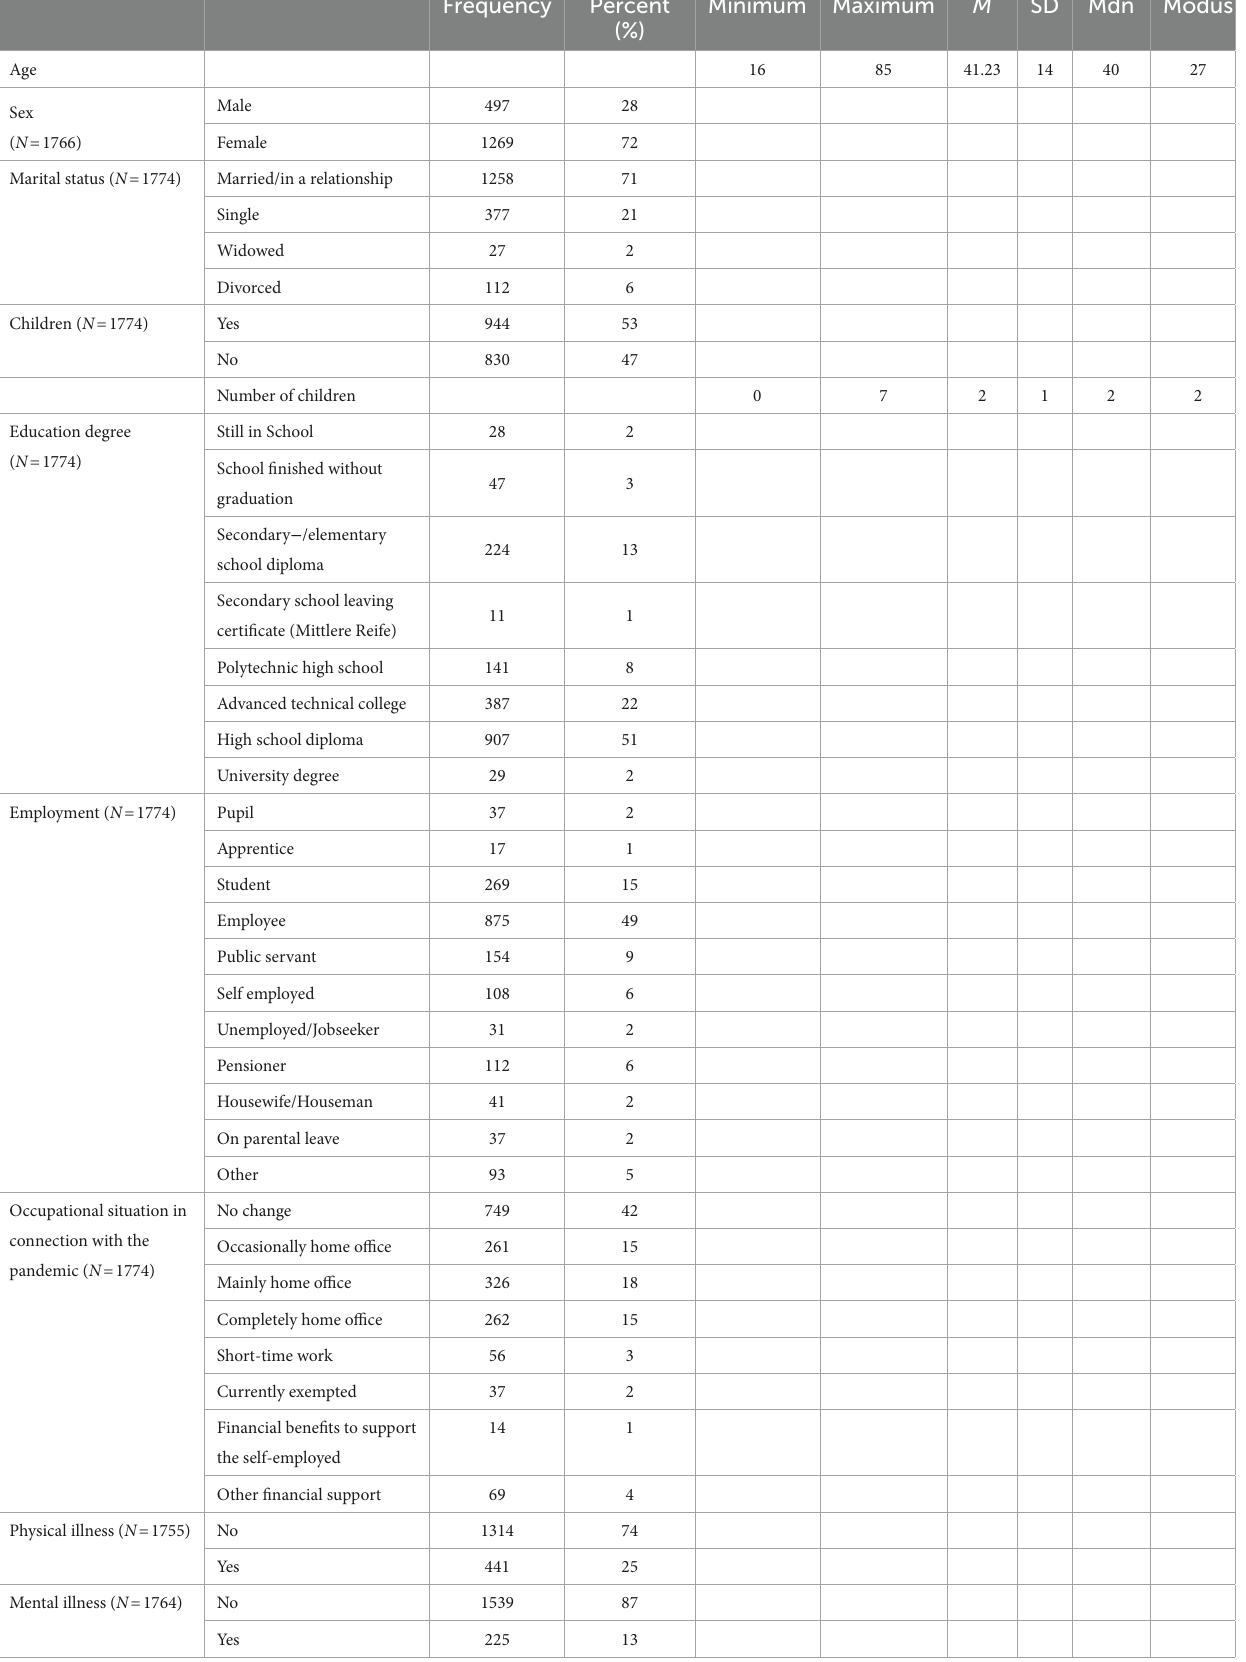
TABLE 1 Summary of sample demographic